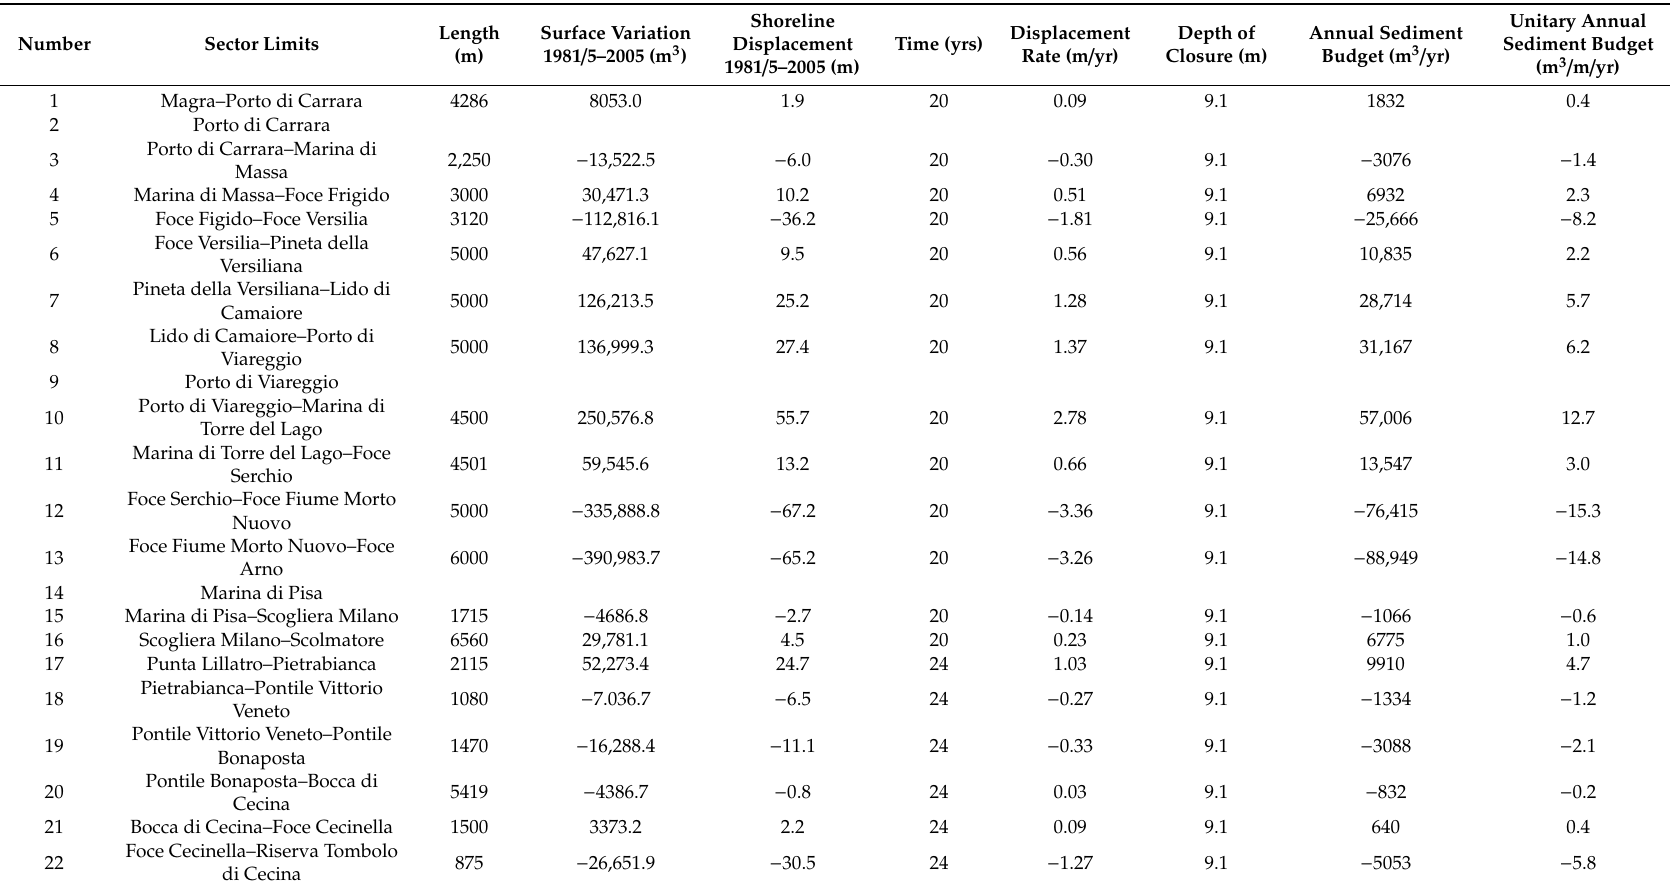
Table A1. Sectors in which the Tuscany continental beaches have been divided and related parameters. Investigated time changes from sector to sector depending on the specific year in which the starting survey was performed, always within the 1981–1985 time